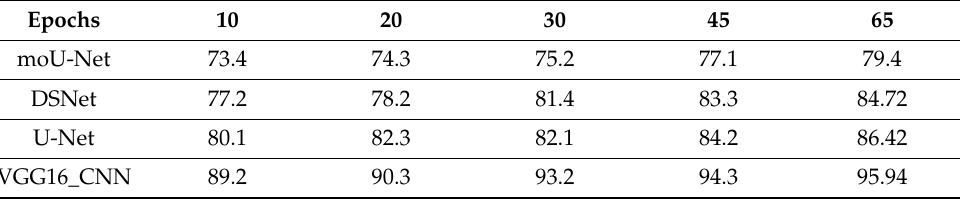
Table 3. Comparison of precision over various epochs between existing techniques and proposed methodology.